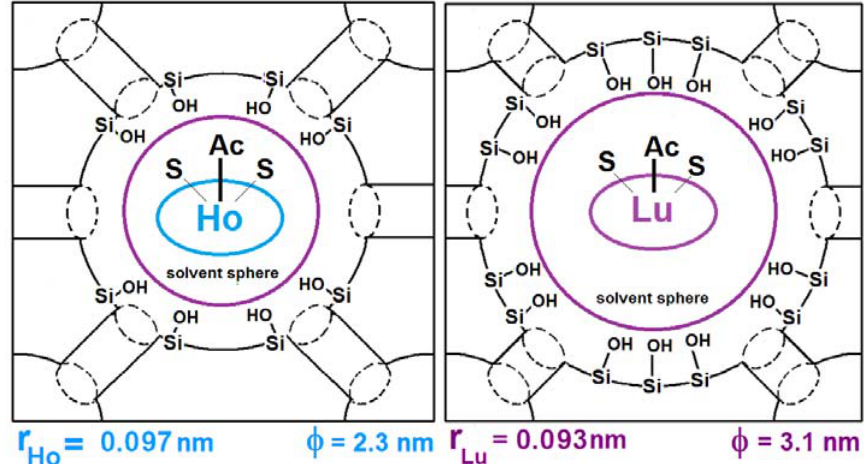
Figure 10. The average pore size of cavities formed around solvated Ln(TPP)As·2S species are a function of the ionic radius of the lanthanide atom that is present in the complex trapped inside the silica